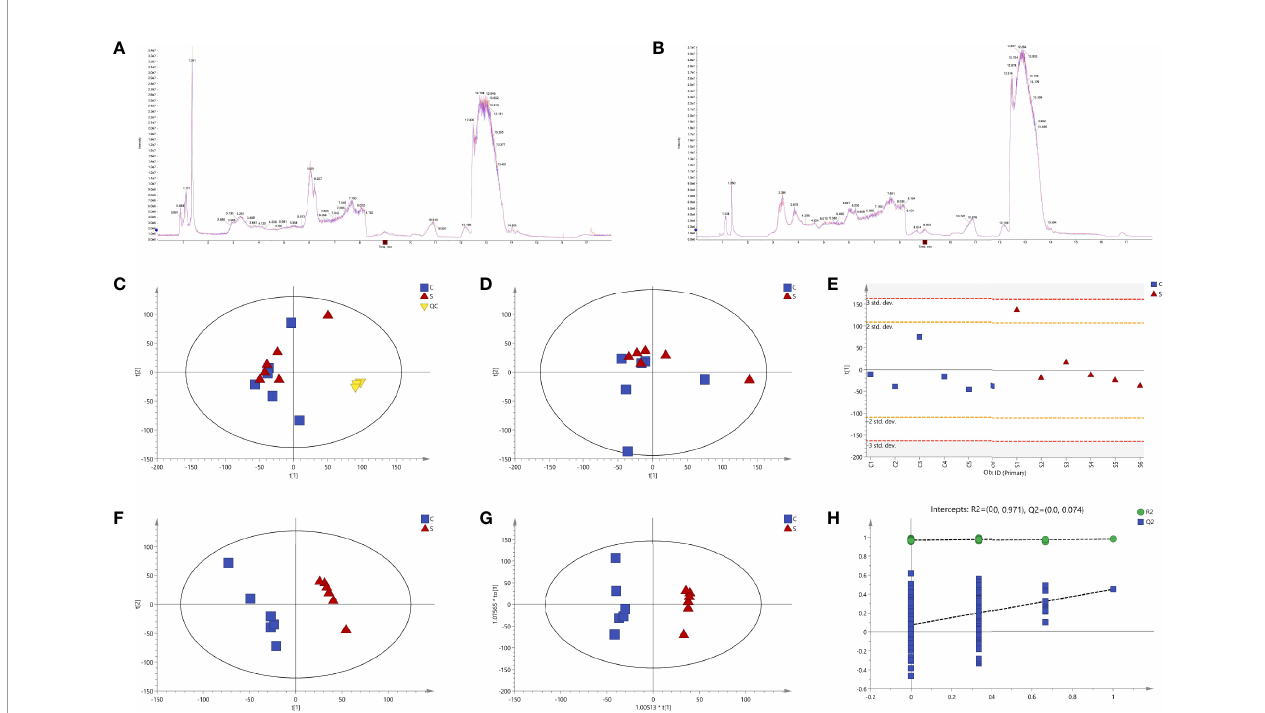
FIGURE 2 | Quality control (QC) and multivariate statistical analyses. Total ion chromatograms (TICs) of QC samples in positive (A) and negative (B) ion modes. Model of unsupervised principal component analysis (PCA) with (C) or without (D) QC samples. Score plot of the fi rst principal component (PC1) (E) . Supervised partial least squares discriminant analysis (PLS-DA) (F) . Orthogonal partial least squares discriminant analysis (OPLS-DA) (G) . A 200-time permutation test for evaluating the OPLS-DA model (H)